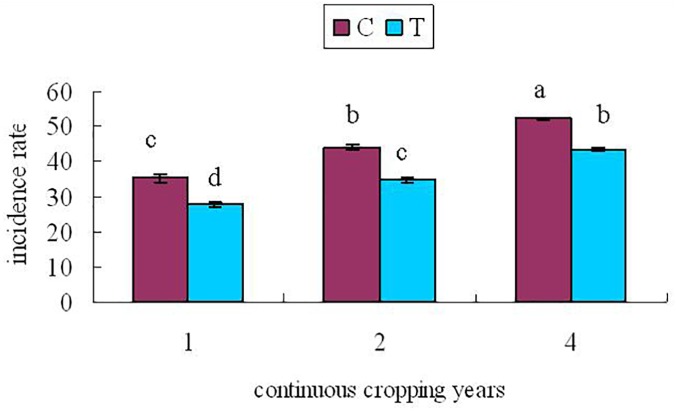
Soybean root rot index At 60 days after planting. C, control group; T, treatment group; x-axis 1, 2, and 4 represents the years of continuous cropping. Vertical bars represent the standard deviation of the means. Lowercase indicate significant differences at 0.05 level.